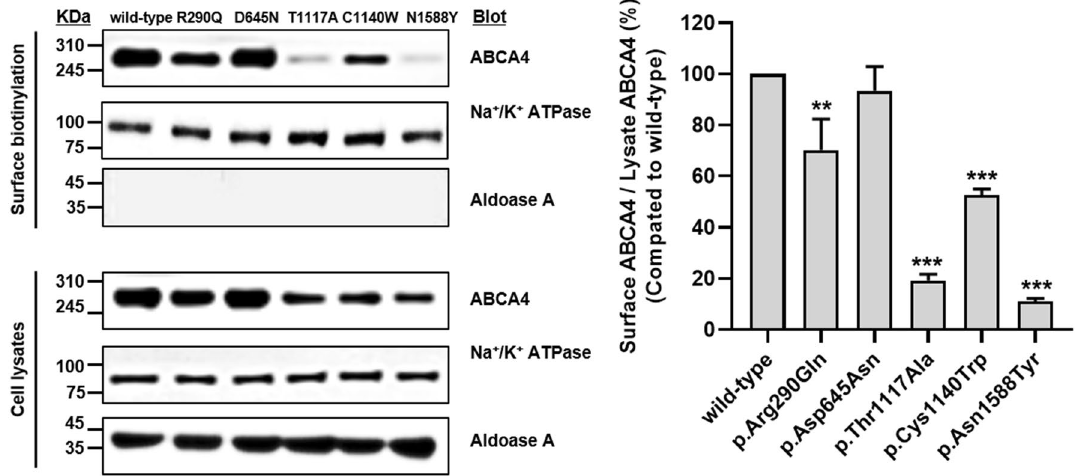
Figure 1. Effect of ABCA4 variants on ABCA4 surface expression. HEK-293T cells were transfected with ABCA4 wild-type or variant plasmids, and a surface biotinylation assay was conducted. Images were cropped, and full-length blots were presented in Supplementary Fig. 1. Data represent the mean ± SD from three independent experiments analyzed using one-way analysis of variance followed by Dunnett’s two-tailed test. ** P < 0.01, *** P < 0.001 versus